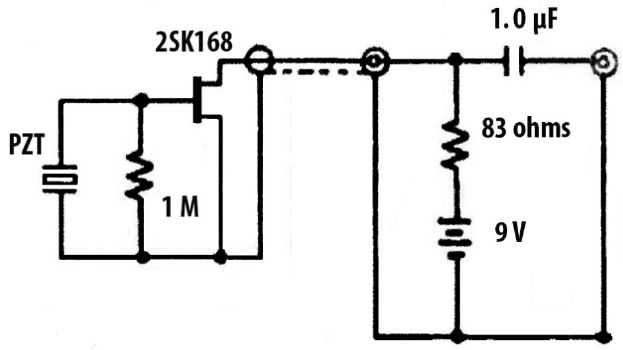
Figure A9. Circuit diagram of an FET buffer.